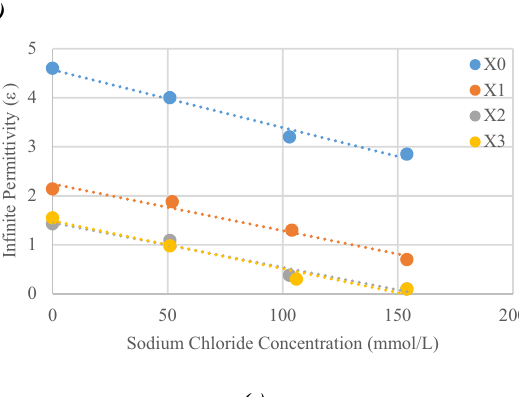
Figure 5. Cole–Cole Model parameters for various concentrations in sodium chloride and sucrose. X corresponds to letters A to D in Table 3. ( a ) Static permittivity, ( b ) relaxation time, ( c ) conductivity, ( d ) dispersion factor and ( e ) infinite